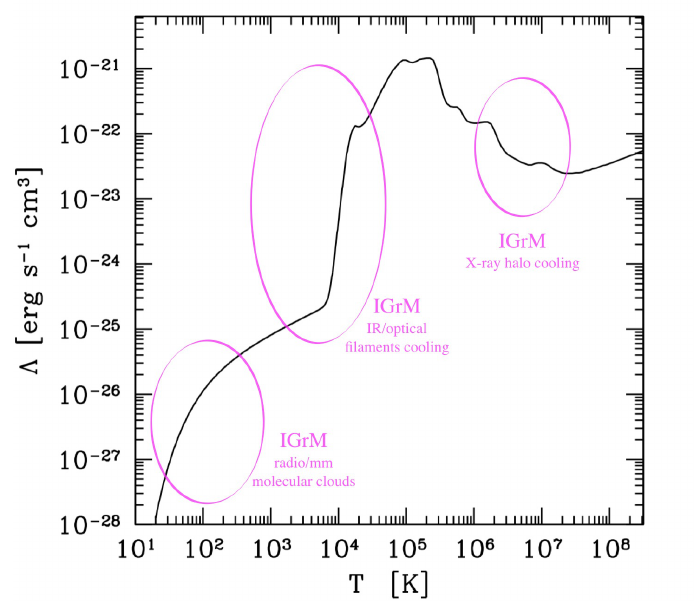
Figure 10. Multiwavelength cooling function for the IGrM (adapted from Gaspari et al. [166], unifying the atomic/plasma physics studies by Sutherland and Dopita [227], Dalgarno and McCray [230], Inoue and Inutsuka [231]; Z = 1 Z (cid:12) ), which was specifically used for a typical galaxy group akin to NGC5044. Above the neutral hydrogen recombination ( T ∼ 10 4 K), the gas is fully ionized and in collisional ionization equilibrium; below this threshold, the gas becomes progressively less ionized ( (cid:46) 1%), leading to the formation of neutral filaments and, subsequently, dense molecular clouds. The three magenta ellipses highlight the three key (semi)stable phases of the condensing IGrM, in particular during the feeding dominated part of the AGN cycle that is shown in Figure 9 (bottom